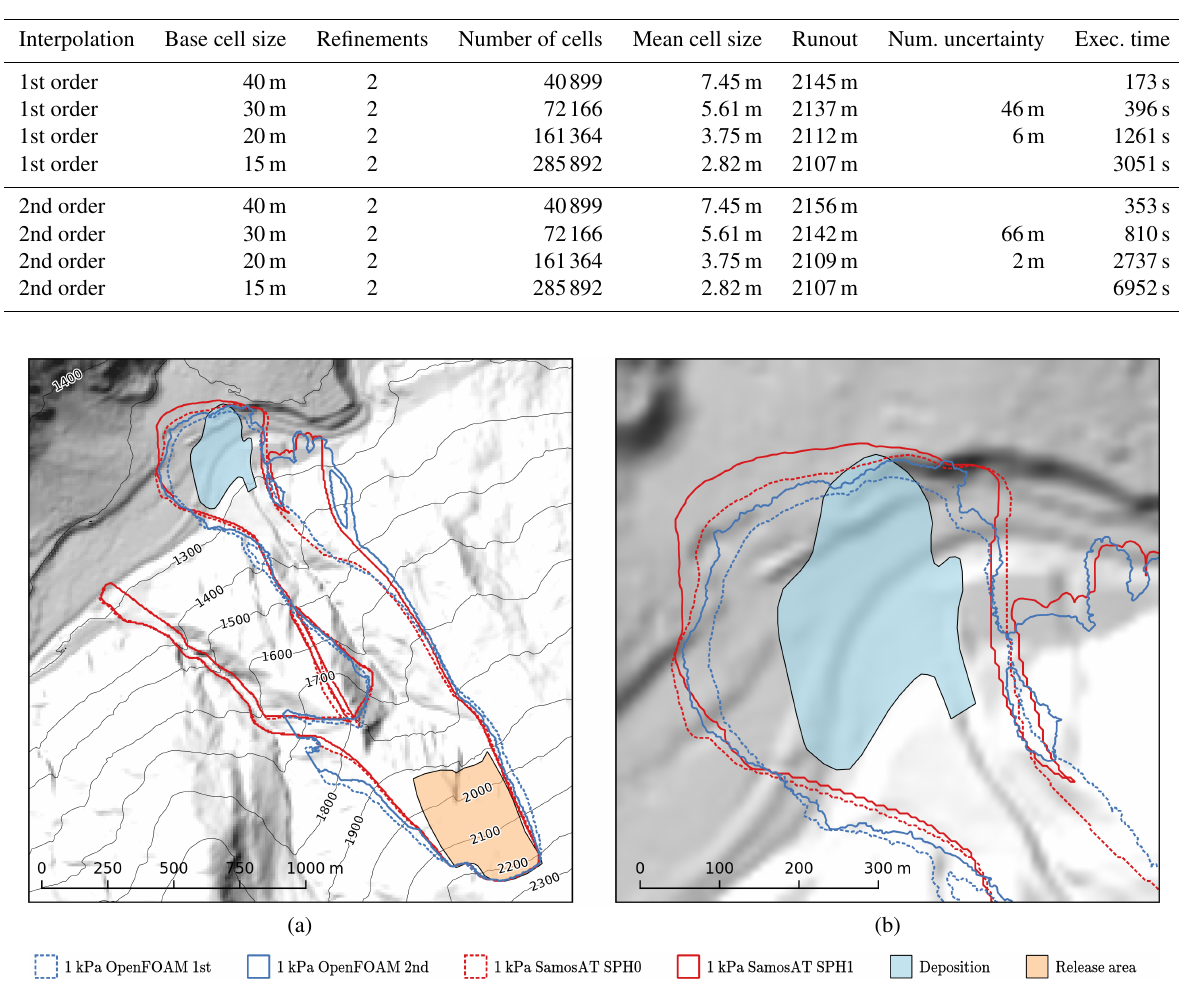
Figure 7. Comparison of OpenFOAM first order (blue, dashed), OpenFOAM second order (blue), SamosAT SPH 0 (red, dashed) and SamosAT SPH 1 (red) in terms of 1kPa isolines (affected area). OpenFOAM results are based on the mesh with cell size (cid:49) = 7 . 45m. The documented release area (orange area) and documented deposition area (blue area) are shown for orientation. The shape and reach of the main avalanche branch are similar in all simulations; secondary branches differ to some extent. Overview (a) and focus on the runout zone (b) . Terrain data: